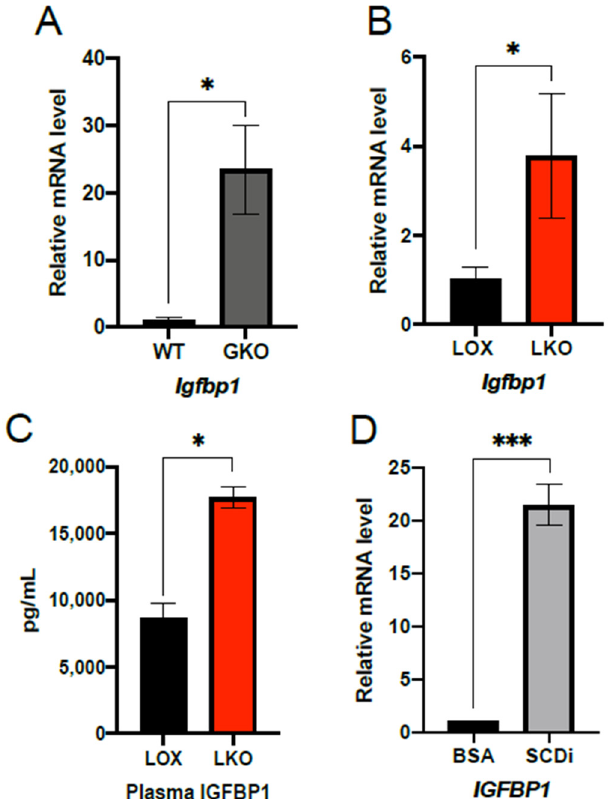
Figure 1. Hepatic SCD1 deficiency up-regulates IGFBP1. ( A ) Relative hepatic Igfbp1 mRNA levels in 8–10 weeks old male WT (n = 4) and GKO (n = 6) mice fed HCD for 10 days. ( B ) Relative hepatic Igfbp1 mRNA levels in 8–13 weeks old male LOX (n = 13) and LKO (n = 12) mice fed HCD for 7–10 days. ( C ) Plasma IGFBP1 protein concentration in 8–10 weeks old male LOX (n = 7) and LKO (n = 7) mice fed HCD for 7–10 days. ( D ) Relative IGFBP1 mRNA levels in HepG2 cells treated for 24 h with BSA (n = 10) or BSA plus 4 μ M (n = 12) of SCD inhibitor. Values are mean ± SEM; * p < 0.05 vs. WT, LOX, or BSA, *** p < 0.005 vs. WT, LOX or BSA by Student’s two-tailed t -test.